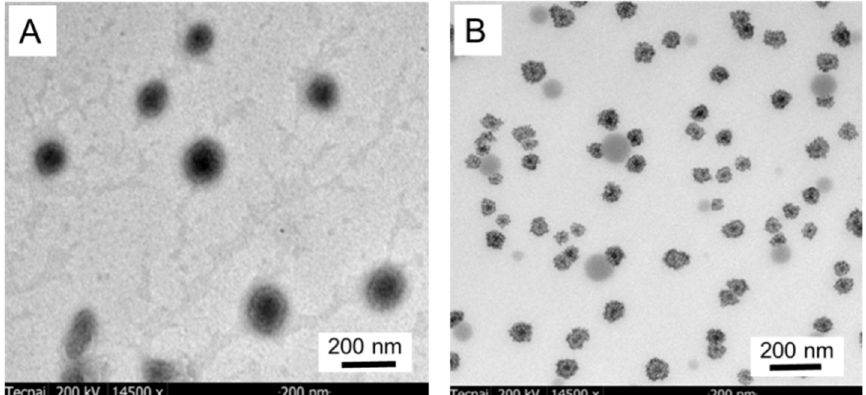
Figure 1. TEM analysis of the blank PF108 micelles ( A ) and QEO-loaded micelles ( B ).